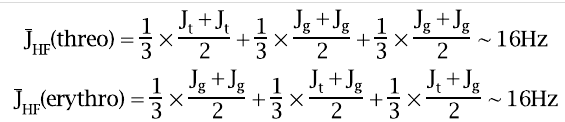
Figure 17: The average coupling constant with no conformational bias. The limiting coupling constants J g = 8 Hz and J t = 32 Hz are estimated values.